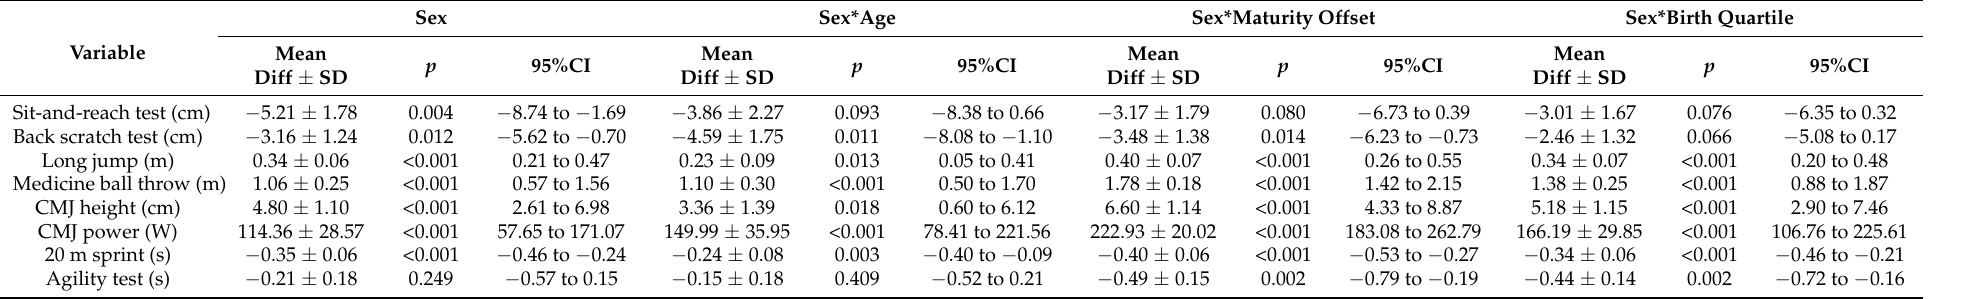
Table 4. Post hoc Bonferroni adjustement for the different covariates for the physical fitness